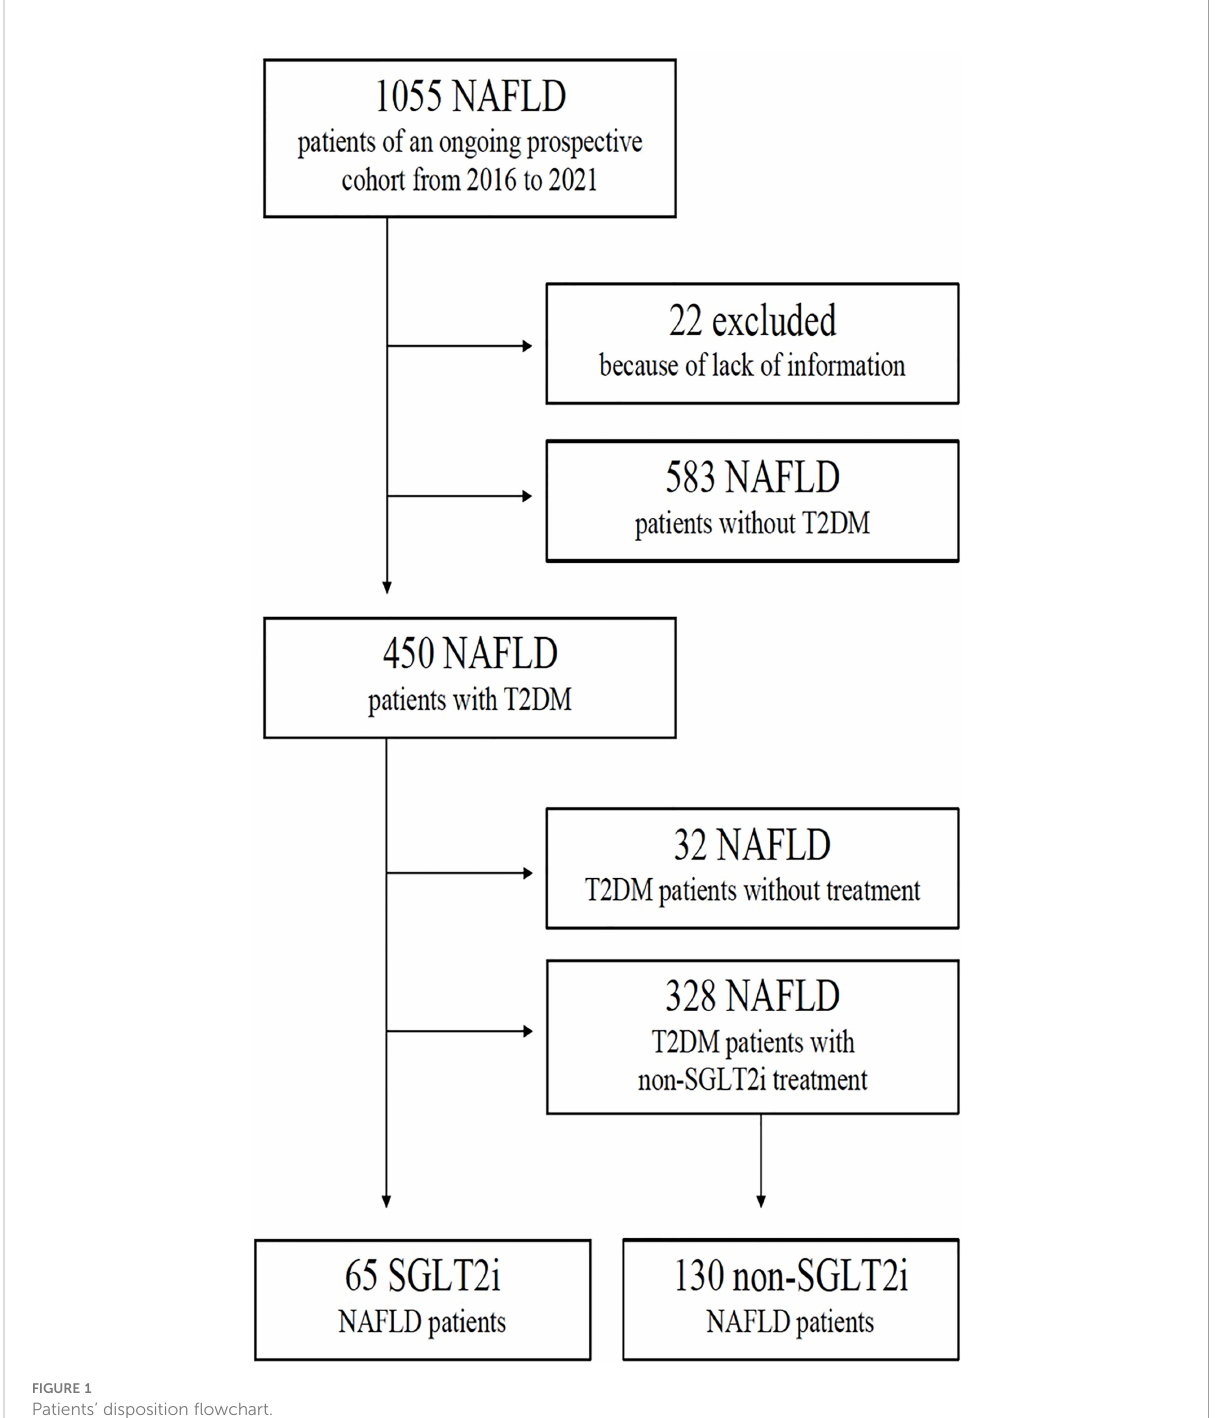
FIGURE 1 Patients ’ disposition fl